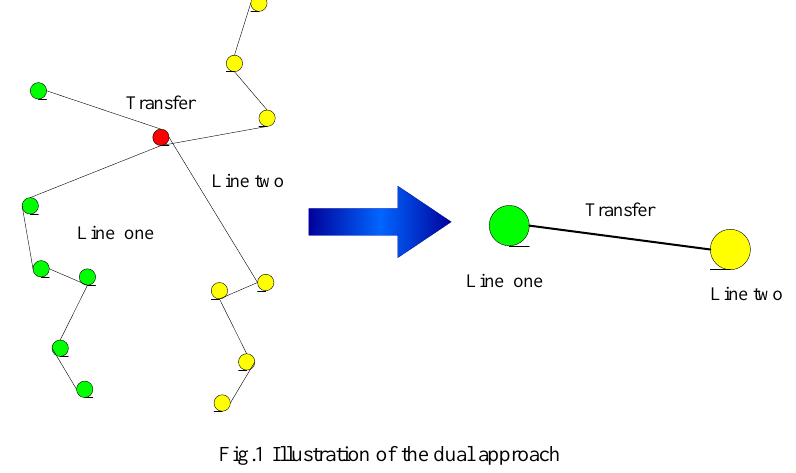
Fig.1 Illustration of the dual